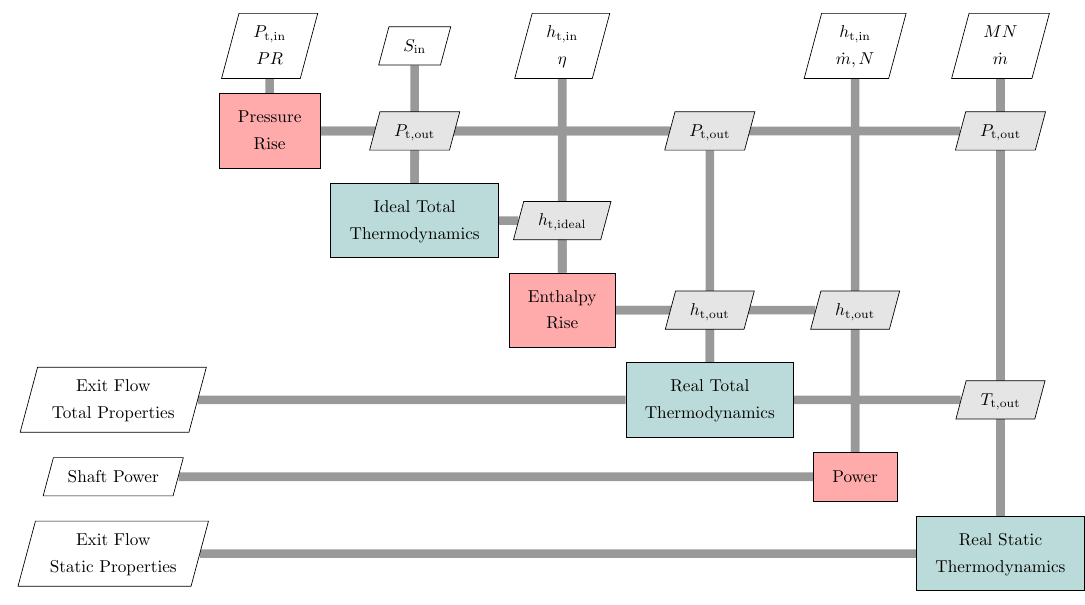
Figure 3. Internal structure of the pyCycle compressor